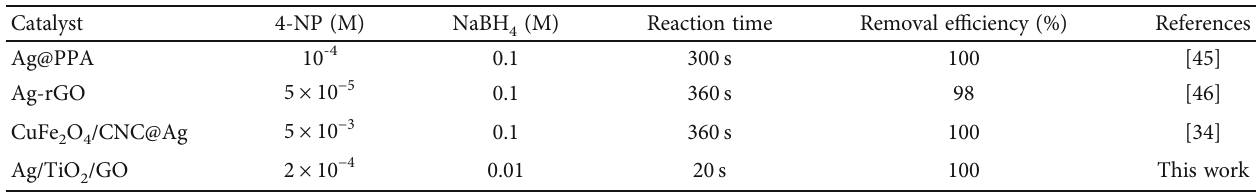
Table 2: Comparison catalytic performance of several reported AgNP-based nanomaterials to remove 4-NP (concentration, reaction time, and removal performance); poly(acrylic acid) (PPA); reduced-GO (rGO); cellulose nanocrystals (CNC).